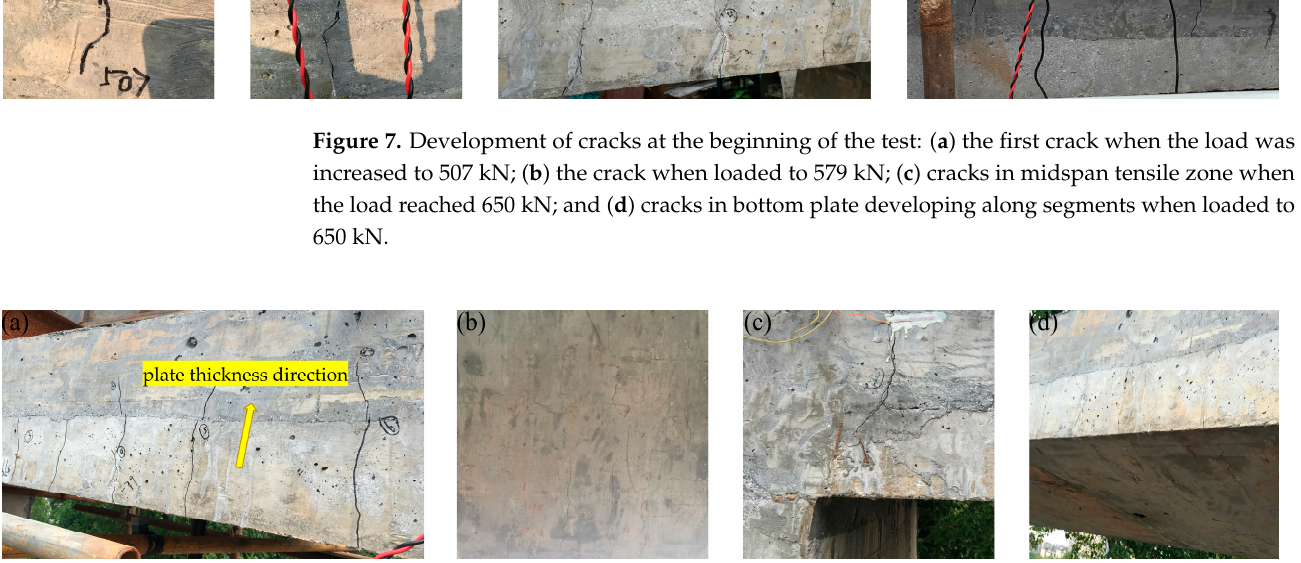
Figure 8. Development of cracks at the end of the test: ( a ) cracks in top plate developing along thickness direction when the load was increased to 722 kN; ( b ) long cracks when the load reached 794 kN; ( c ) a main crack in midspan tensile zone when loaded to 848 kN; and ( d ) cracks in top plate after test was stopped.